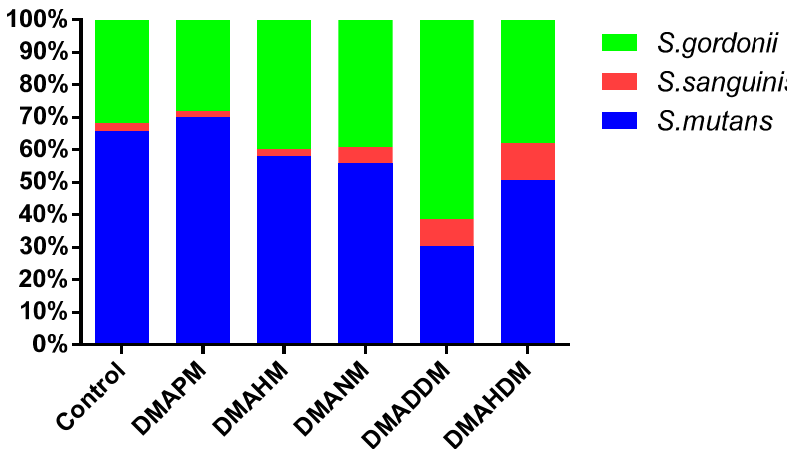
Figure 3. Microbial composition of three-species biofilms on adhesive disks, counted using the TaqMan real-time polymerase chain reaction.